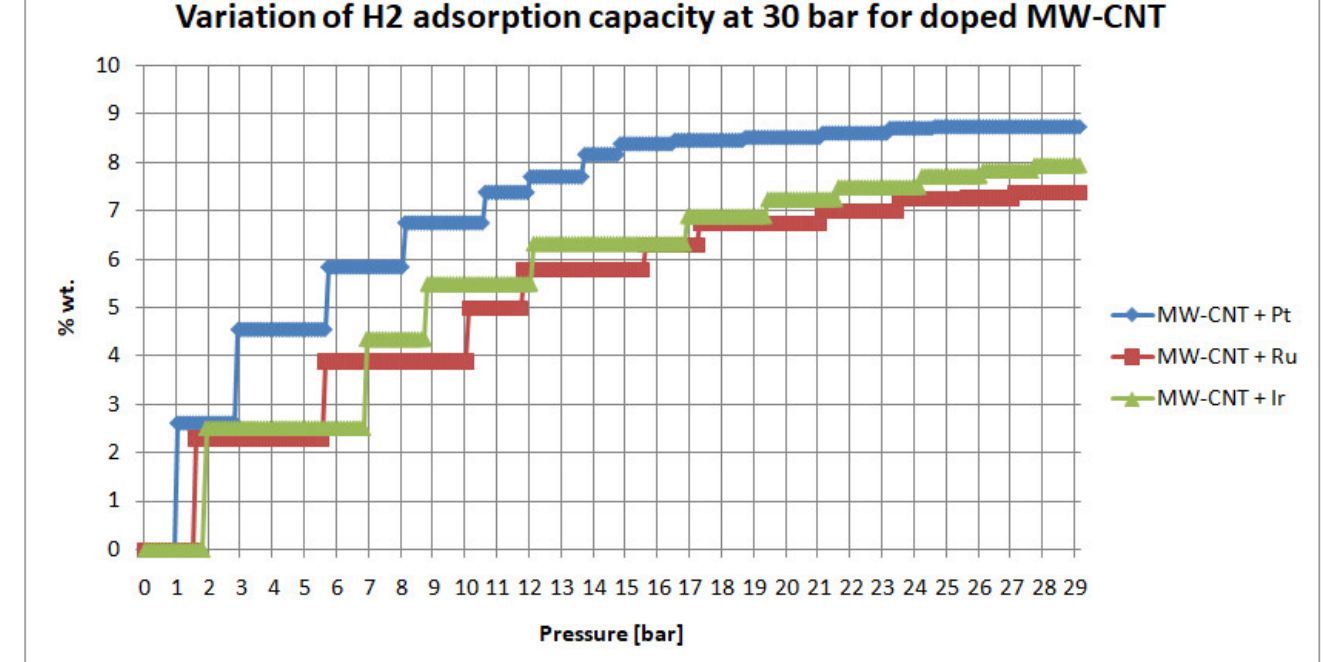
Figure 7. Metal-doped MW-NT H 2 -adsorption-capacity determination at 30 bar.